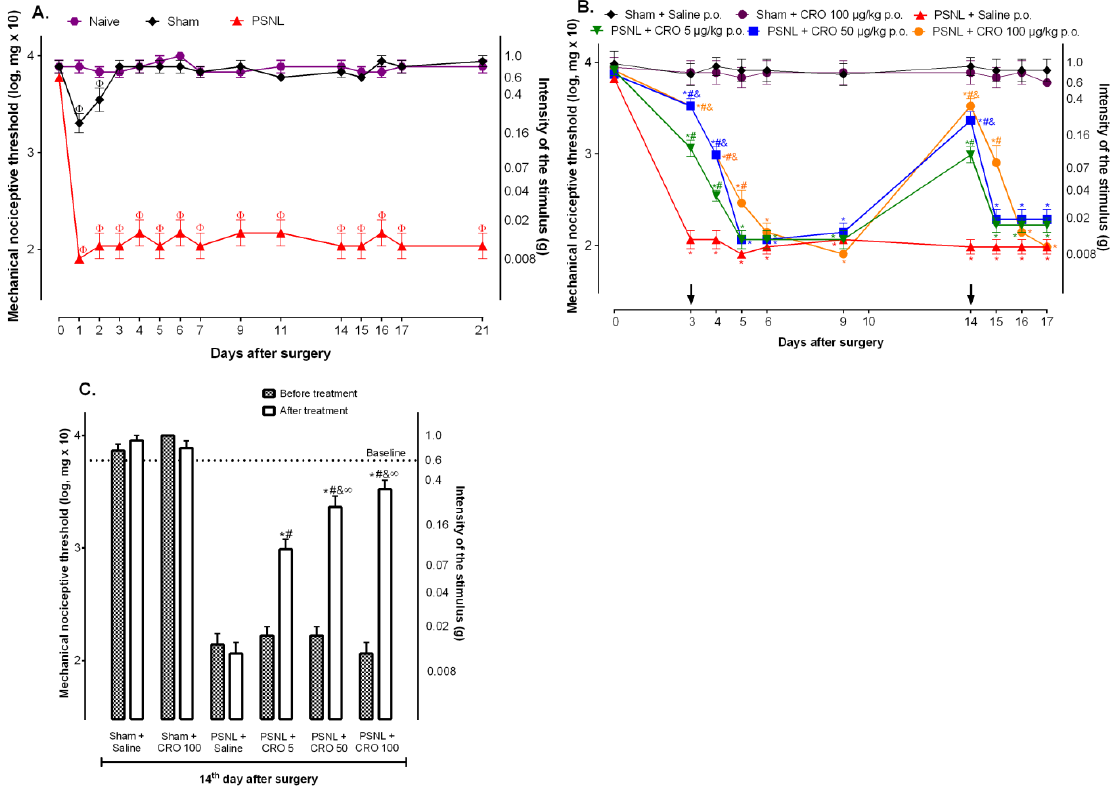
Figure 1. Investigation of crotalphine effect in the partial sciatic nerve injury (PSNL) model-indu ced hypernociception. Mice were submitted to surgery (sham or PSNL) and underwent behavioral testing from day 0 (baseline) to the 21st ( A ) day after surgery. Mice were treated with crotalphine (5, 50, and 100 µg/kg — CRO) (p.o.) on the 3rd and 14th ( B , C ) days after surgery (arrows). The nociceptive threshold was evaluated before, or 1 h after treatment ( C ), and on the following days using von Frey filaments. The results are expressed by the mean ± SEM ( n = 5). Φ p < 0.05 indicates a statistical difference when compared to the Naive. * p < 0.05 indicates a statistical difference when compared to the Sham + Saline. # p < 0.05 indicates a statistical difference when compared to the PSNL + Saline. & p < 0.05 indicates a statistical difference when compared to the PSNL + CRO group 5 µg/kg. ∞ p < 0.05 indicates a statistical difference when compared before and after treatment groups. The two-way ANOVA test was used followed by Tukey ’s test.